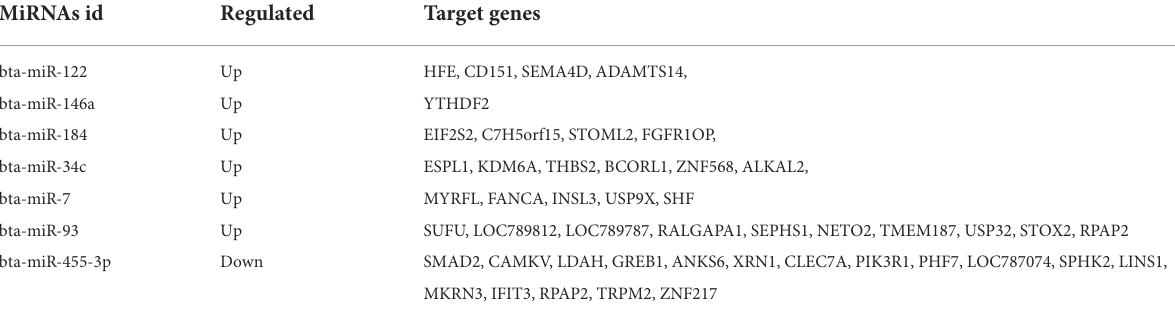
TABLE 3 The list of differentially expressed miRNAs and their target genes of H vs. P. MiRNAs id Regulated Target